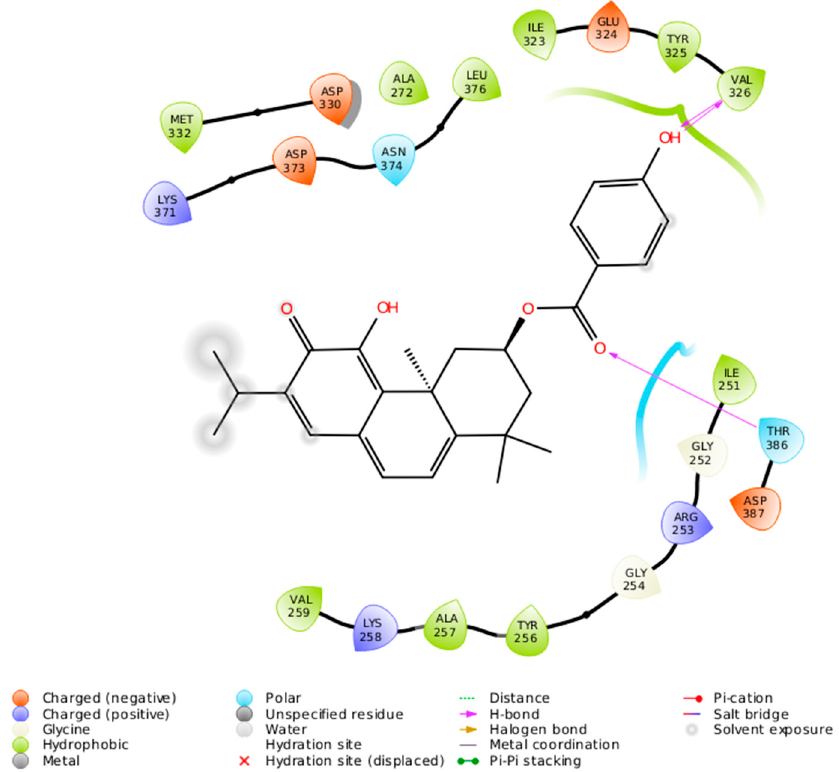
Figure 7. Intermolecular protein–ligand interactions for ParvD ( 3 ) in the binding site of PKC ι.